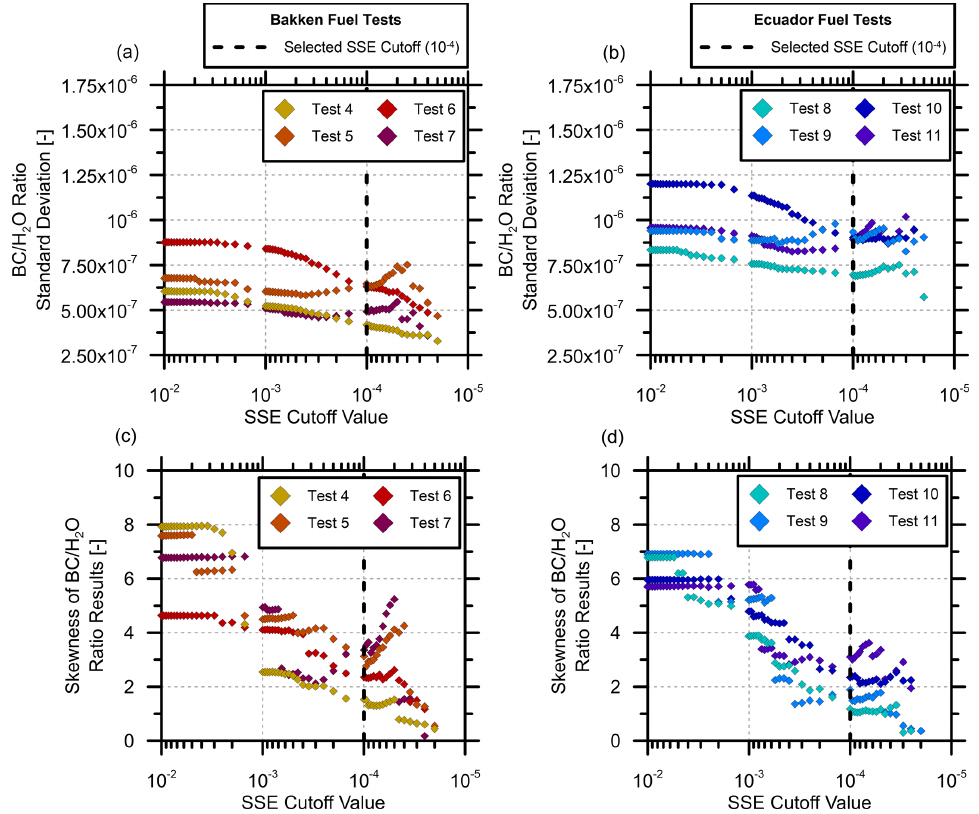
Figure A5. SSE-filtering effect on BC / H 2 O ratio statistics. Panels (a, b) show standard deviation for Bakken and Ecuador fuels, and panels (c, d) indicate skewness of ratio.